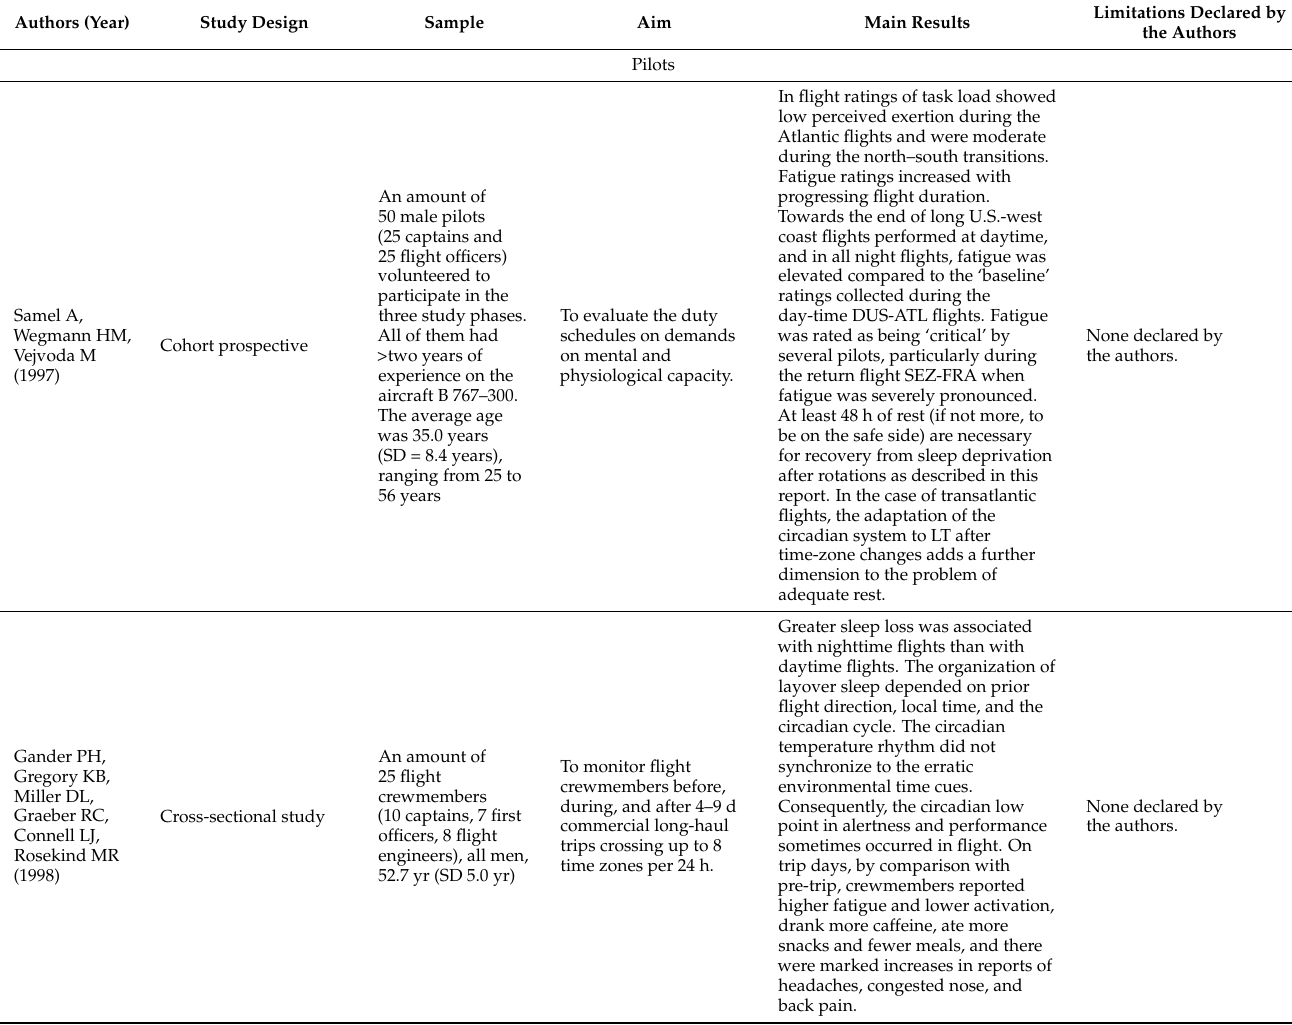
Table 4. Characteristics and main results of studies of airline